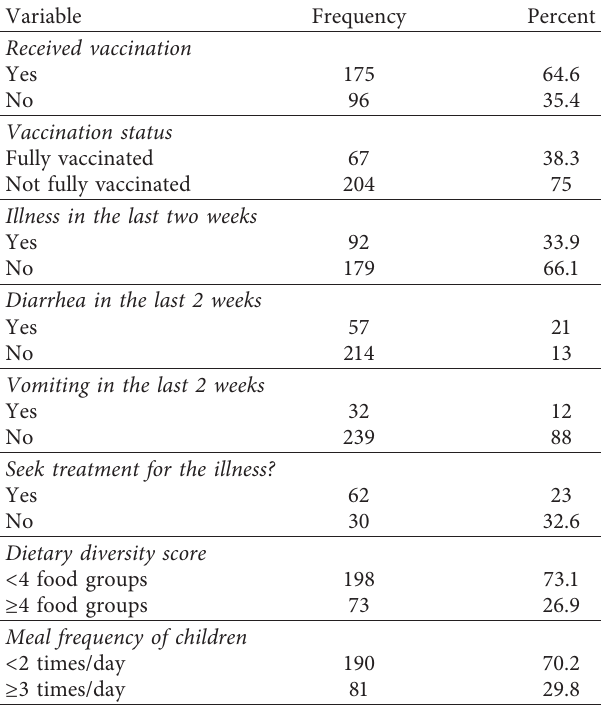
Table 2: Health and diet-related characteristics of orphaned children living in Addis Ababa, Ethiopia, 2020 ( n � 271 ) .